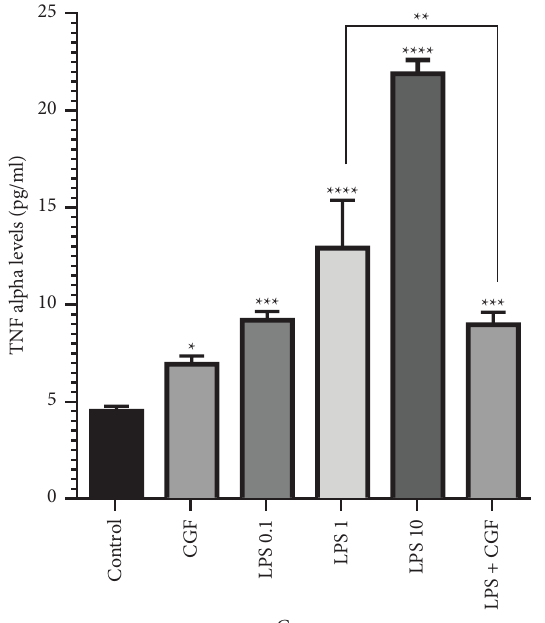
Figure 3: TNF- α levels at the end of the study in the treatment groups; concentrated growth factor (CGF) signifcantly lowered TNF- α production by lipopolysaccharide (LPS) in dental pulp stem cells; ∗∗∗∗ p < 0 . 0001 , ∗∗∗ p < 0 . 001 , ∗∗ p < 0 . 01 , and ∗ p < 0 . 05.